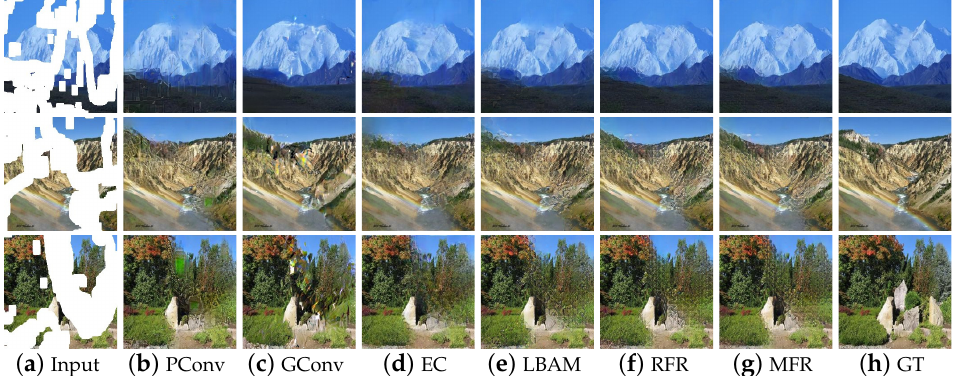
Figure 4. Qualitative comparison on